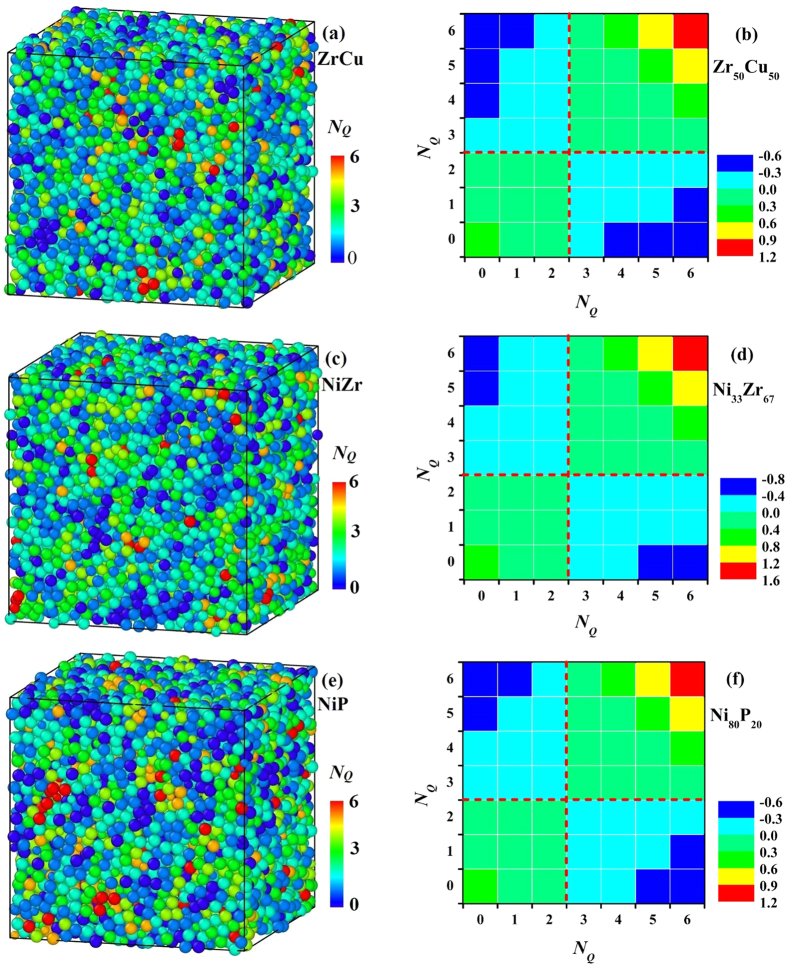
Atom configurations with atoms colored by their NQ for (a) Zr50Cu50, (c) Ni33Zr67 and (e) Ni80P20 at Tg + 150 K. The matrix of spatial correlation index Cij of atoms with different NQ in (b) Zr50Cu50, (d) Ni33Zr67 and (f) Ni80P20 at Tg + 150 K.